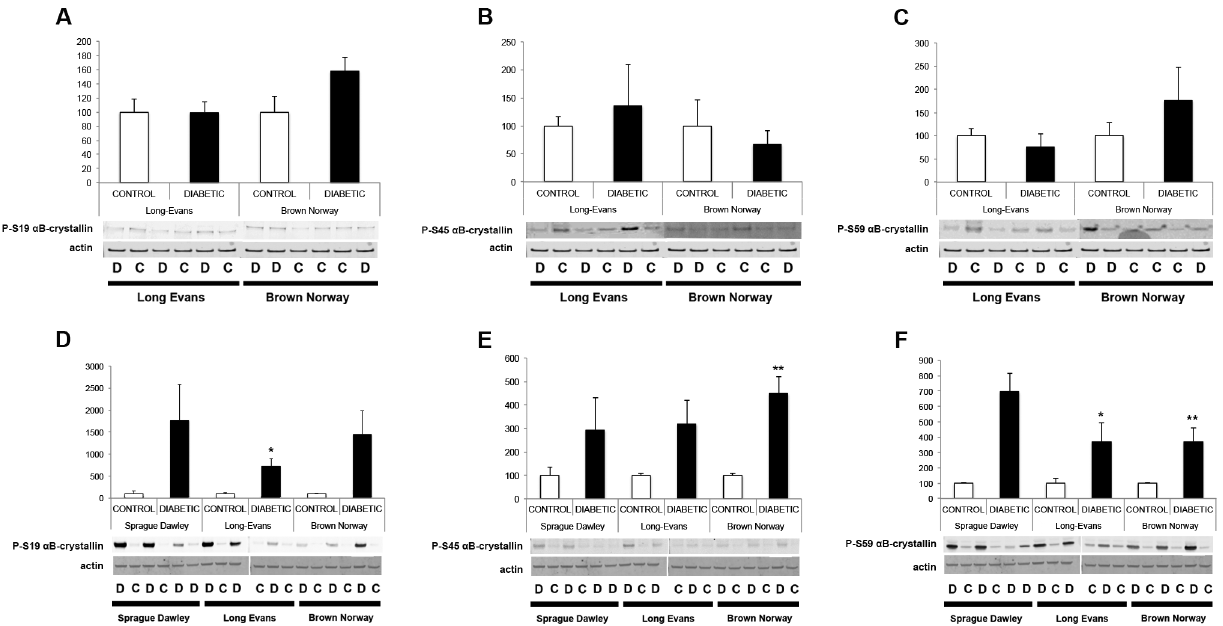
Figure 6. Phosphorylation analysis of alphaB-crystallin during diabetes. The expression of alphaB-crystallin protein phosphorylated at serines 19 (A, D), 45 (B, E) and 59 (C, F) were assessed by Western blot analysis using specific antibodies raised against alphaB-crystallin protein phosphorylated at those sites 4 weeks after the onset of diabetes (A–C) in Long Evans (LE) and Brown Norway (BN) rats. Expression levels were also assessed at 12 weeks (D–F) in Sprague Dawley (SD), in Long Evans (LE) and Brown Norway (BN) rats. Representative immunoblots and graphic representation of the corresponding quantification of the major bands are presented. C, control; D, diabetic. *Significantly different from control [ P , 0.05].